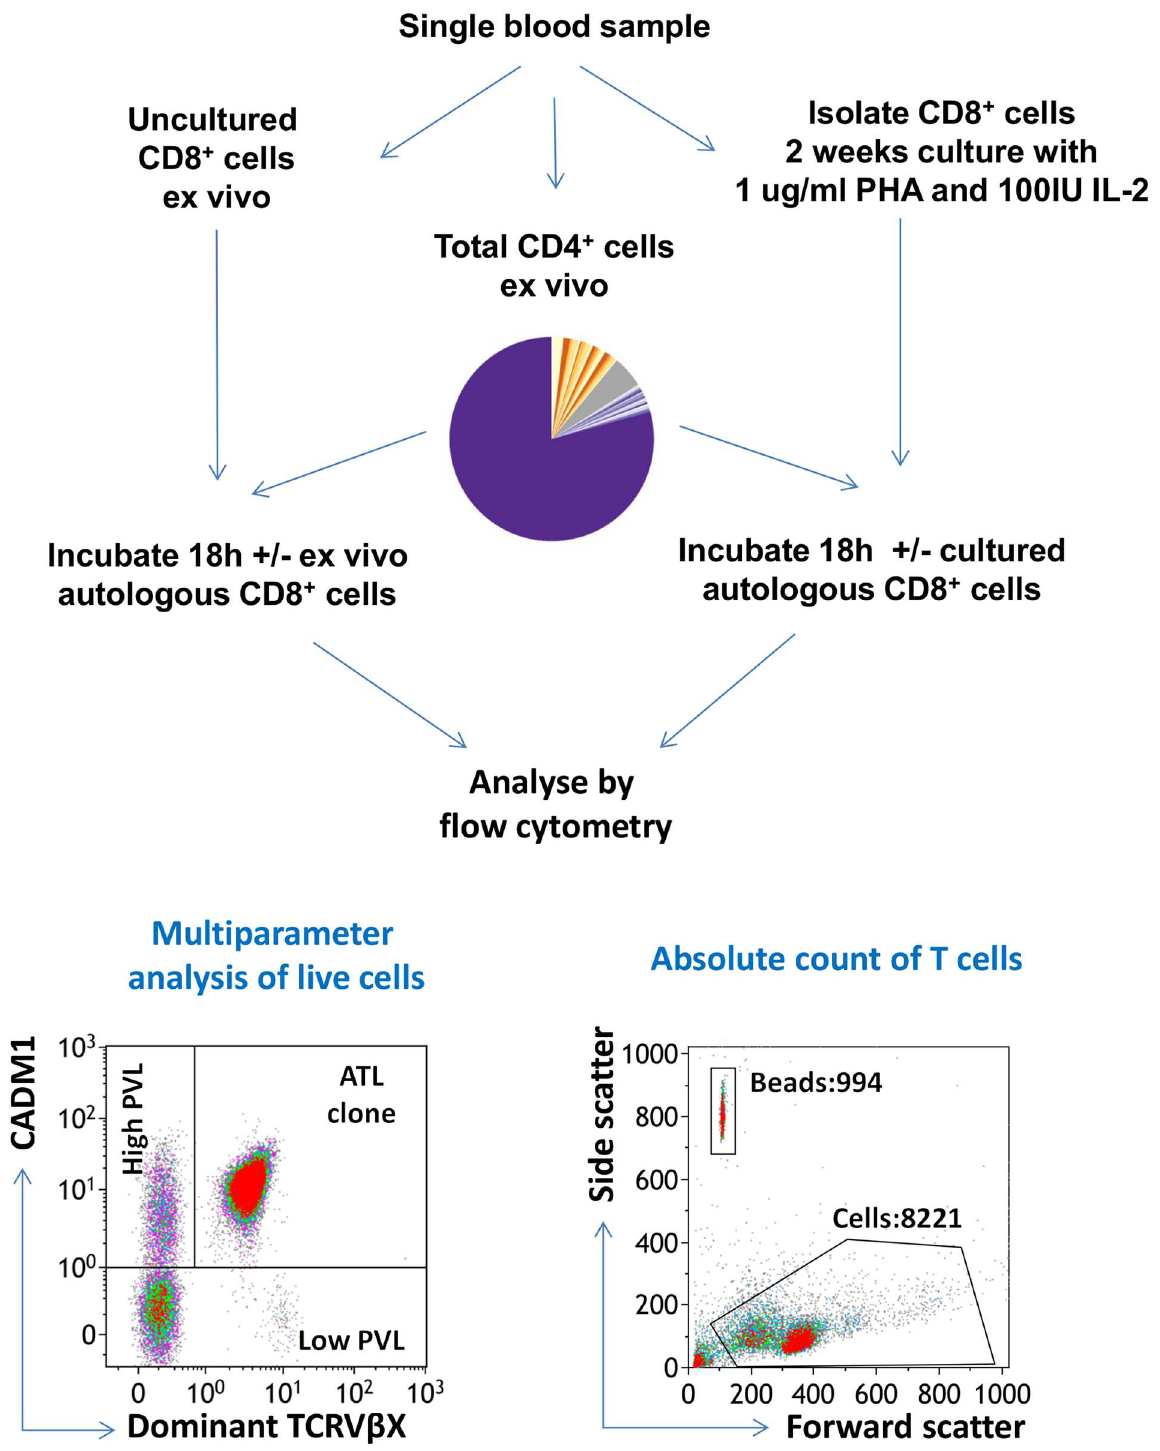
Fig 5. Experimental design of cell survival assay. PBMCs from each of 9 ATL patients with a dominantATL clone detectableby TCRV β stainingwere depletedof CD8 + T cells. The CD8 − PBMCs (CADM1 + CD4 + , purple; CADM1 − CD4 + , yellow) were cultured overnighteither alone or in the presenceof autologousCD8 + cells at a range of ratios, after which cells were stained with a viability stain and antibodies specific for CD3, CD4, CD8, CADM1 and the TCRV β subunitwhich was most frequentlyused in that individual (‘TCRV β X’). Cells were then permeabilised, stainedintracellularly with anti-Tax antibody, and analysedby flow cytometry. Absolute cell counts of CD3 + , CD4 + and CD8 + cells were performed in